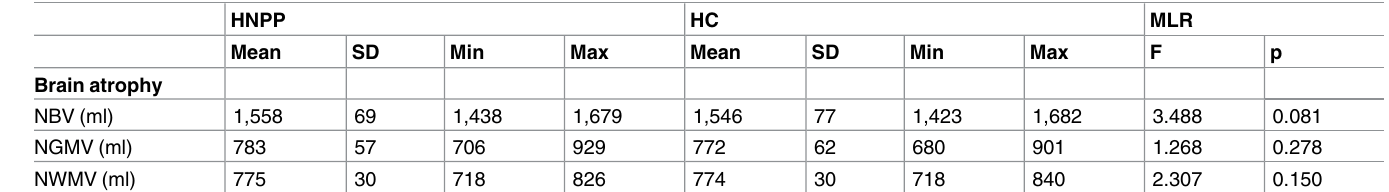
ness was associated with prolonged VEP latencies. MRS in a subset of participants revealed Table 3. Brain atrophy.